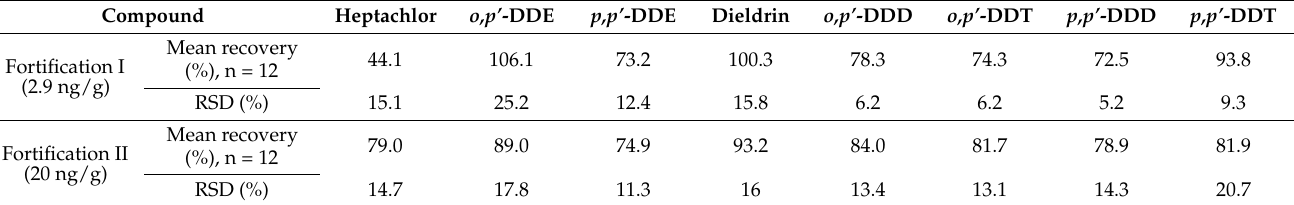
Table 4. Method reproducibility.